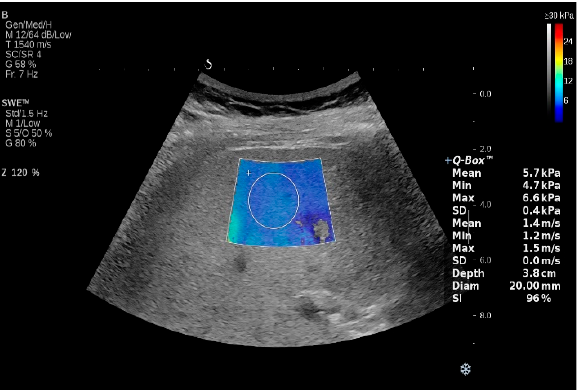
Figure 3. Two ‐ dimensional shear wave elastography (2D ‐ SWE) using SuperSonic equipment. Figure 3. Two-dimensional shear wave elastography (2D-SWE) using SuperSonic